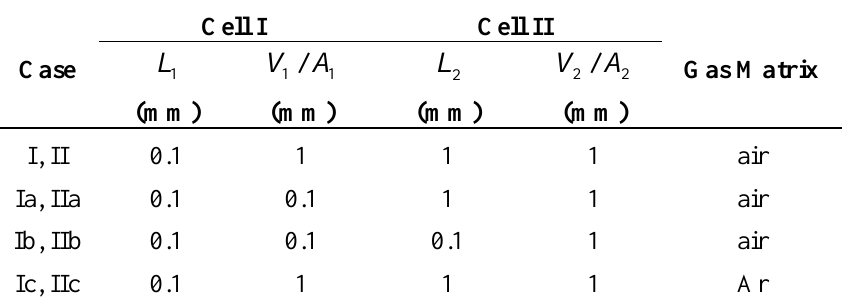
Table 5. Simulated cell configurations and gas matrix